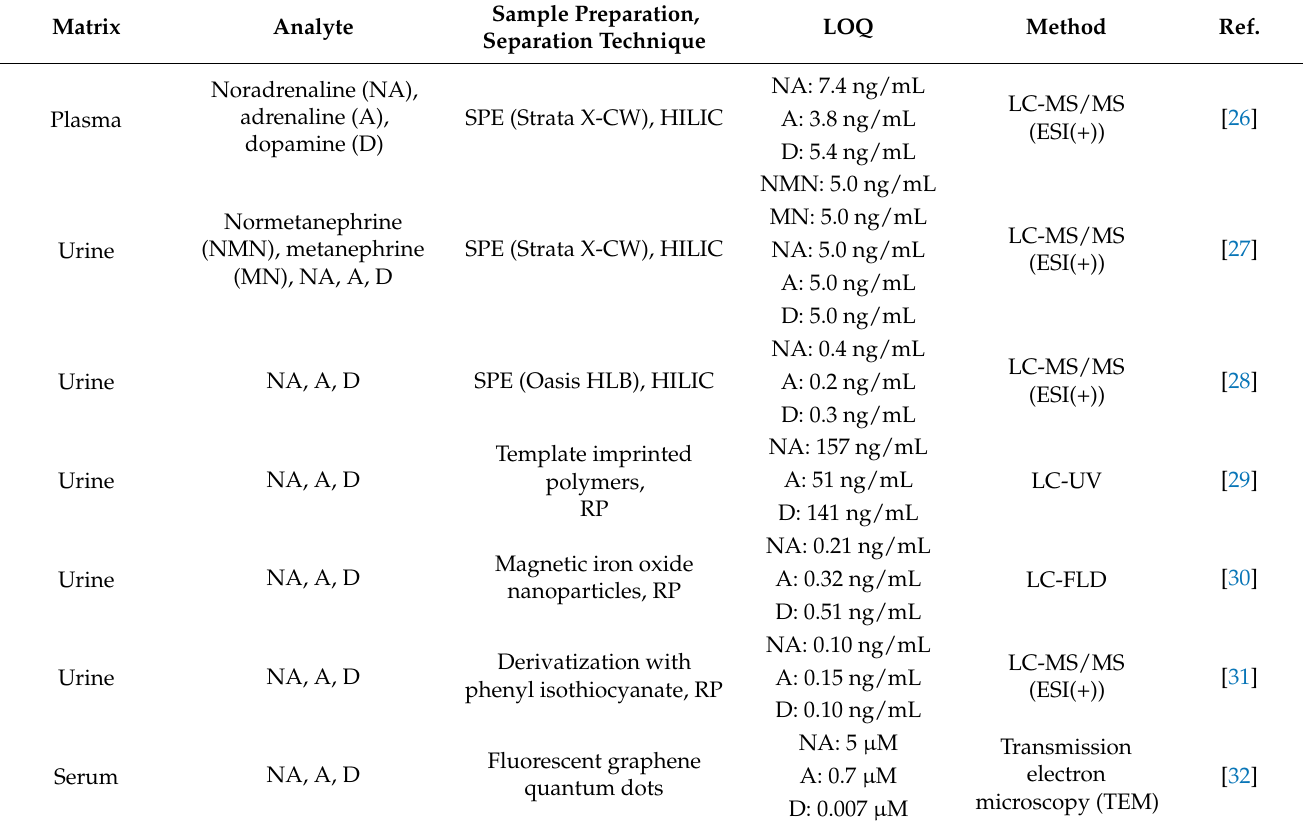
Table 2. An overview of some methods for the determination of